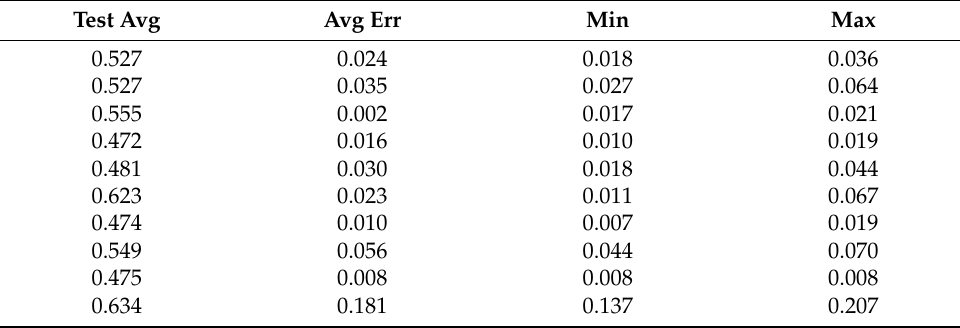
Table A39. Set 1, trials 21–30 data (average actual PR